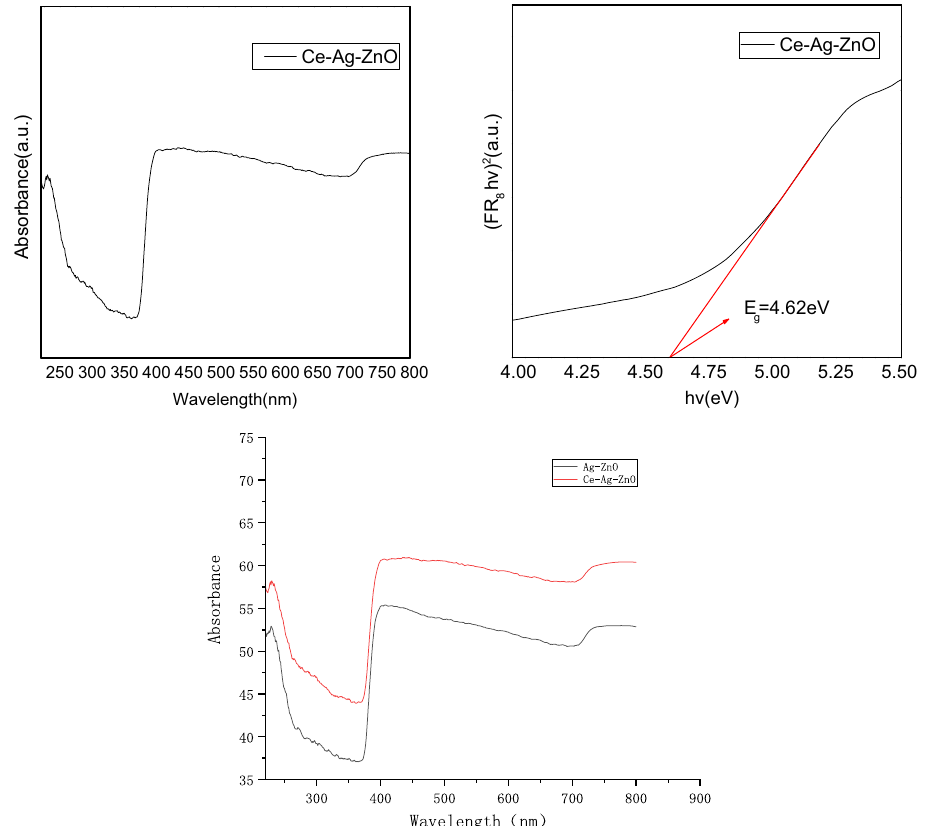
Figure 8: UV - Vis di ff use re fl ection spectroscopy and band gap width of Ag/ZnO and